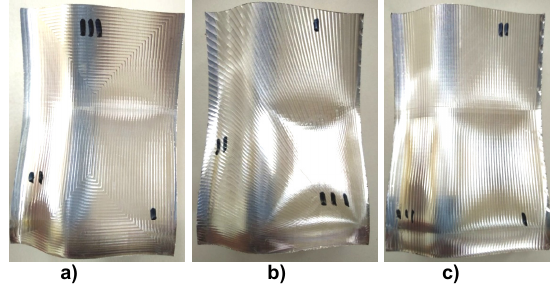
Figure 7. Machined workpiece and surface with marked zones: (a) EXP1, (b) EXP2, and (c) EXP3